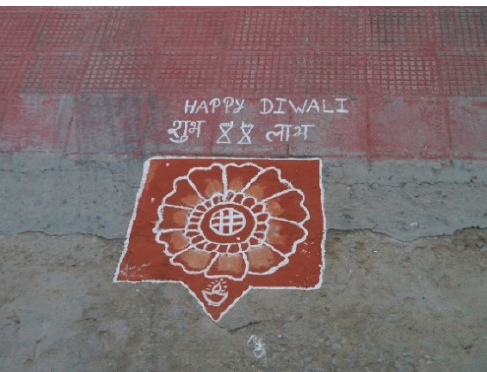
Figure 3. Alpana made of cowdung-paint and chalk, at the doorstep of a residence in Havala during Divali 2017 (picture by author).